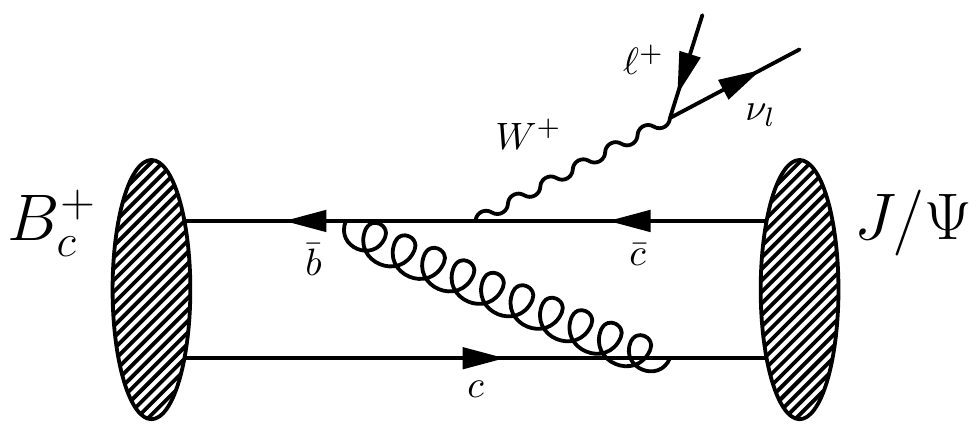
Figure 1 . Schematic picture of the B +